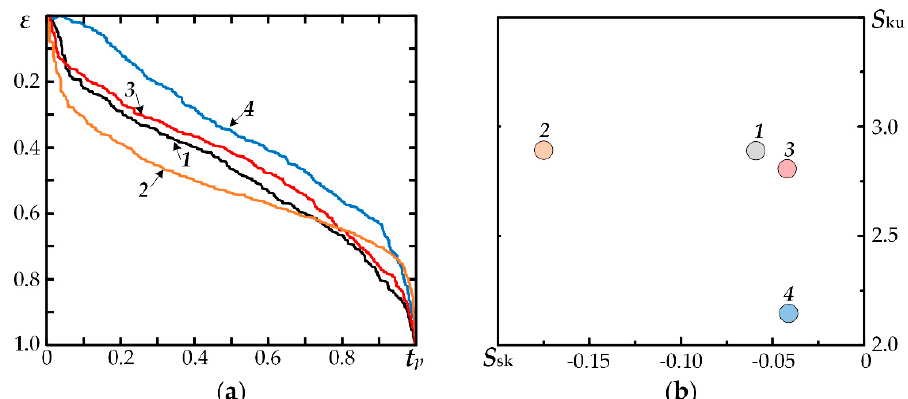
Figure 7. Material ratio curves ( a ) and kurtosis and skewness combination ( b ) of the titanium surface in the initial state ( 1 ), after nitriding at 750 °C ( 2 ) and 900 °C ( 3 ), and after boriding ( 4 ).